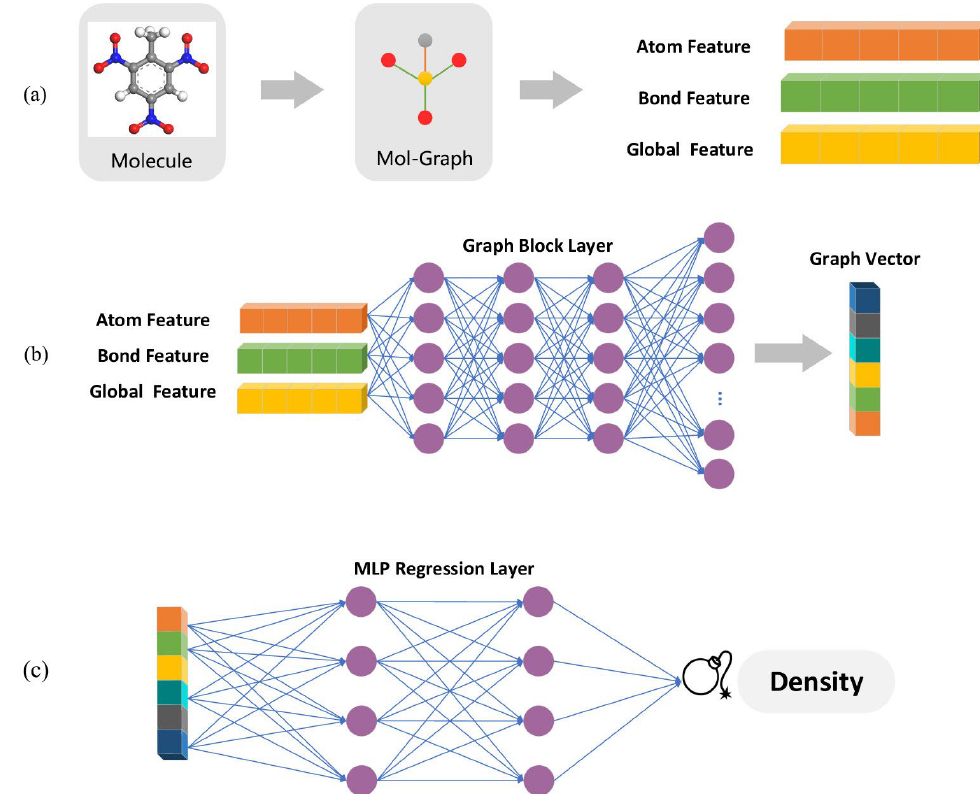
Figure 6. The framework of the density prediction model. ( a ) Extracting features from molecular topologies. ( b ) Vectorising features via a graph block layer. ( c ) Regressing via an ANN model [70]. Copyright 2021 American Chemical Society.